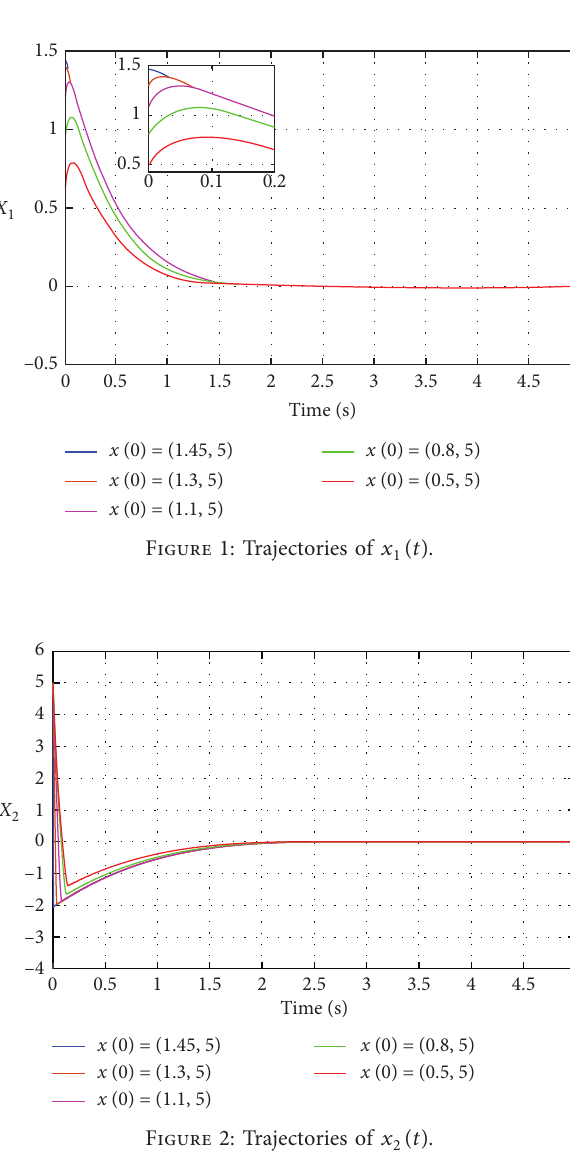
Figure 2: Trajectories of x